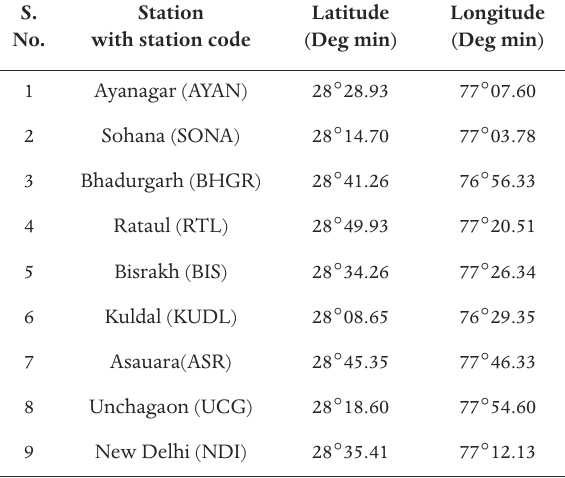
Table 1. Epicentral locations, origin time, date and depths of the events use in the present